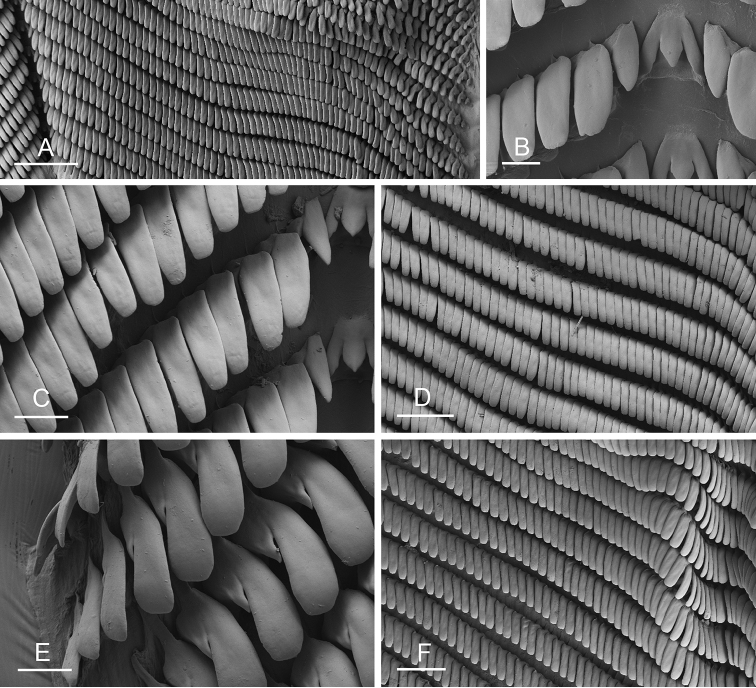
Radula, Peronia
plateiA Papua New Guinea, Madang [5405] (MNHN-IM-2013-13762) B Hawaii, Oahu [6161] (BPBM 284528) C–E Hawaii, Molokai [706] (UF 303653) F [5380] (UF 303653) A right half rows of teeth B rachidian and innermost lateral teeth C rachidian and innermost lateral teeth D lateral teeth E outermost lateral teeth F lateral teeth. Scale bars: 200 μm (A), 20 μm (B, E), 30 μm (C), 100 μm (D), 80 μm (F).